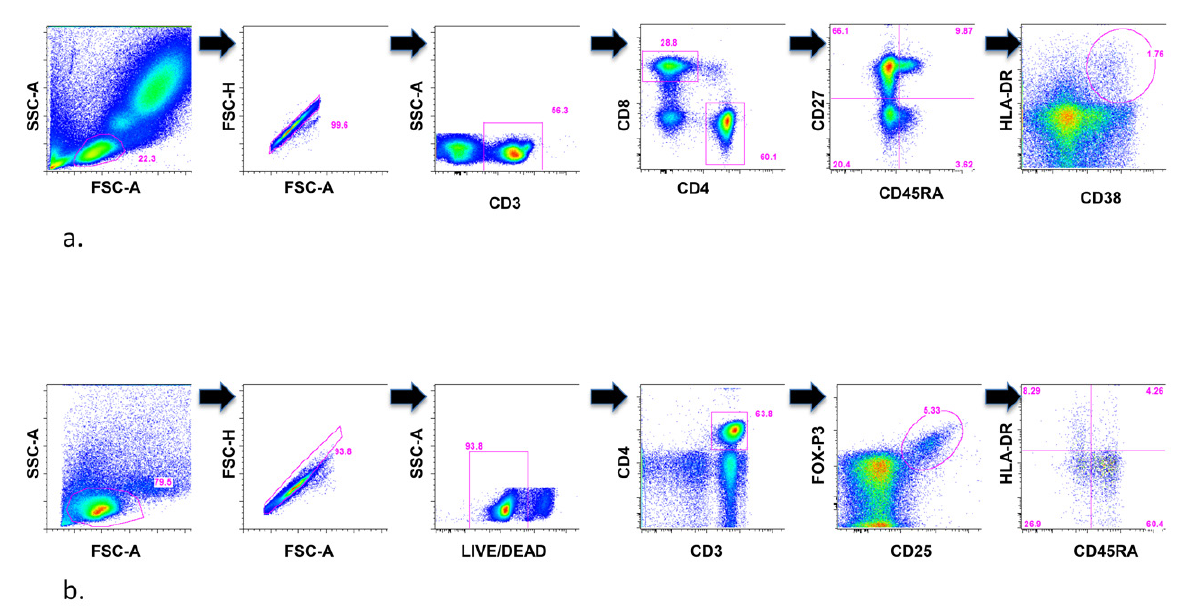
Supplementary Figure 1. Applied gating